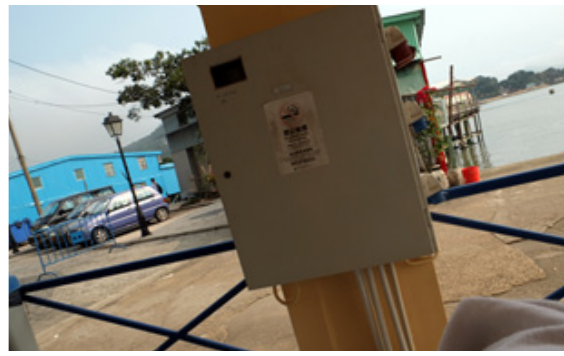
FIGURE 2 | Écho 2, Jerry Chan, 18 th Mar. 2013 Port de Coloane